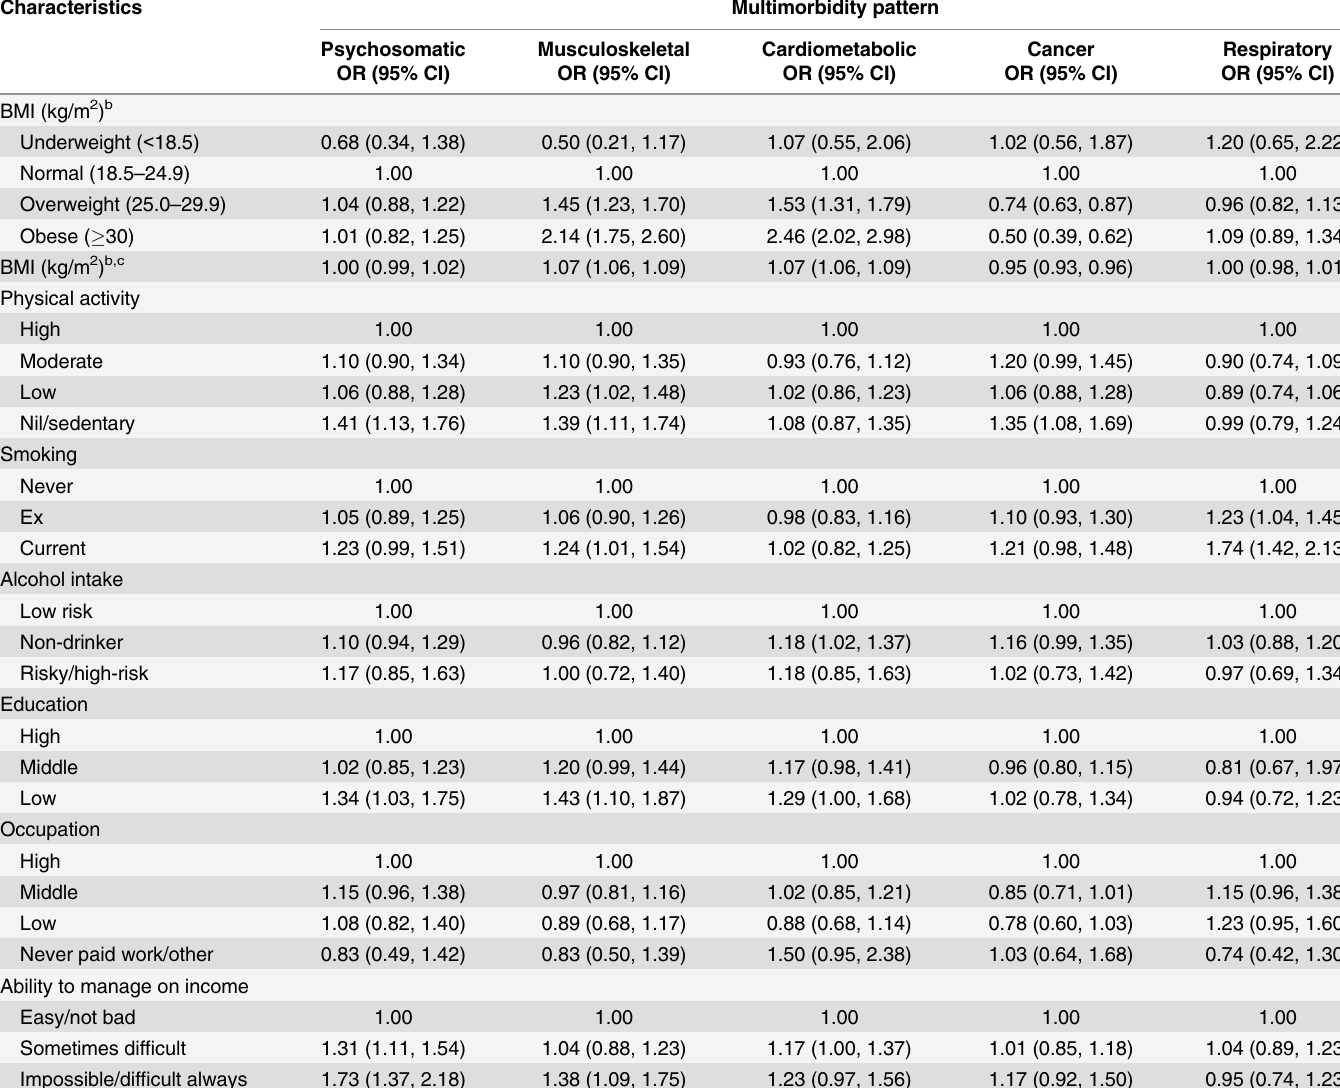
Table 5. Adjusted ORs a of the association between characteristics and a high versus low multimorbidity pattern score.